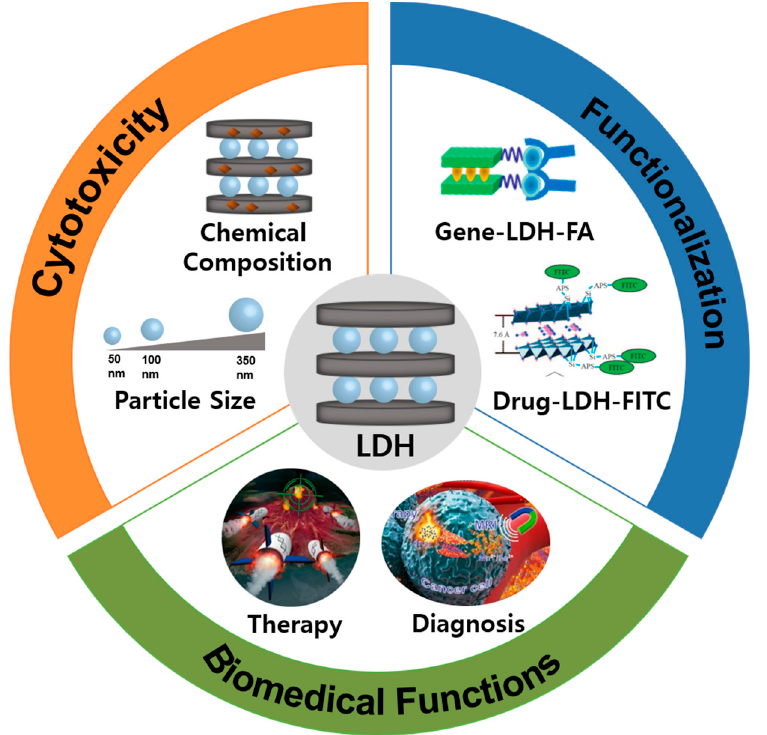
Figure 2. Overview of cytotoxicity of nanoscale hydrotalcite, functional hydrotalcite nanohybrids and their related biomedical applications, reproduced from